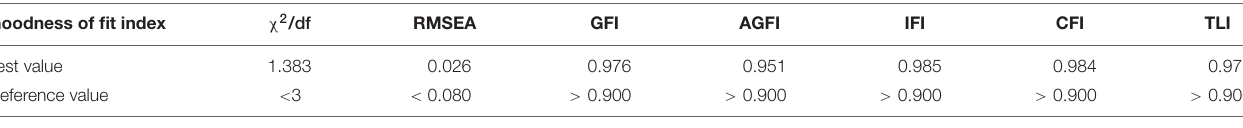
TABLE 3 | Test of Goodness of fit index of the model.